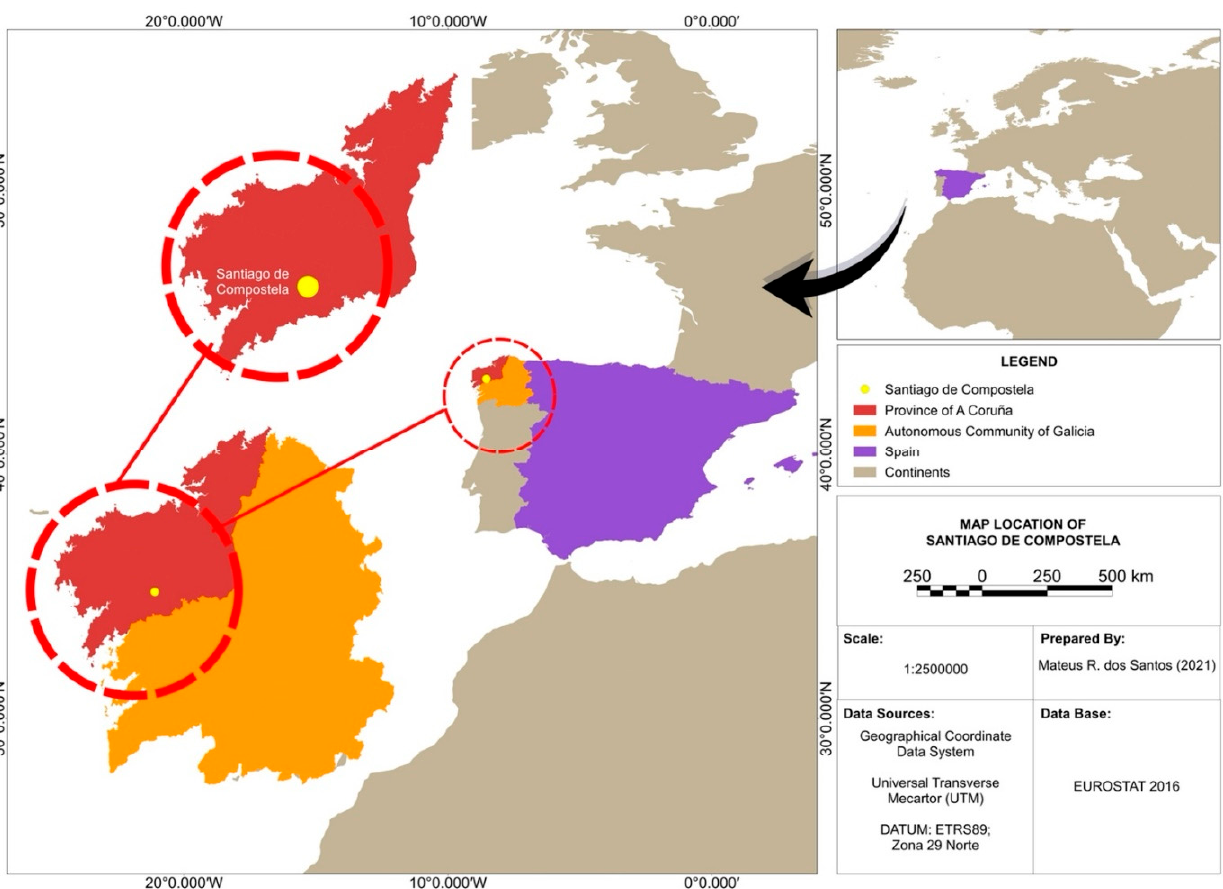
Figure 1. Maps with the location of Santiago de Compostela. Source: Own elaboration (prepared by Mateus R. dos Santos).